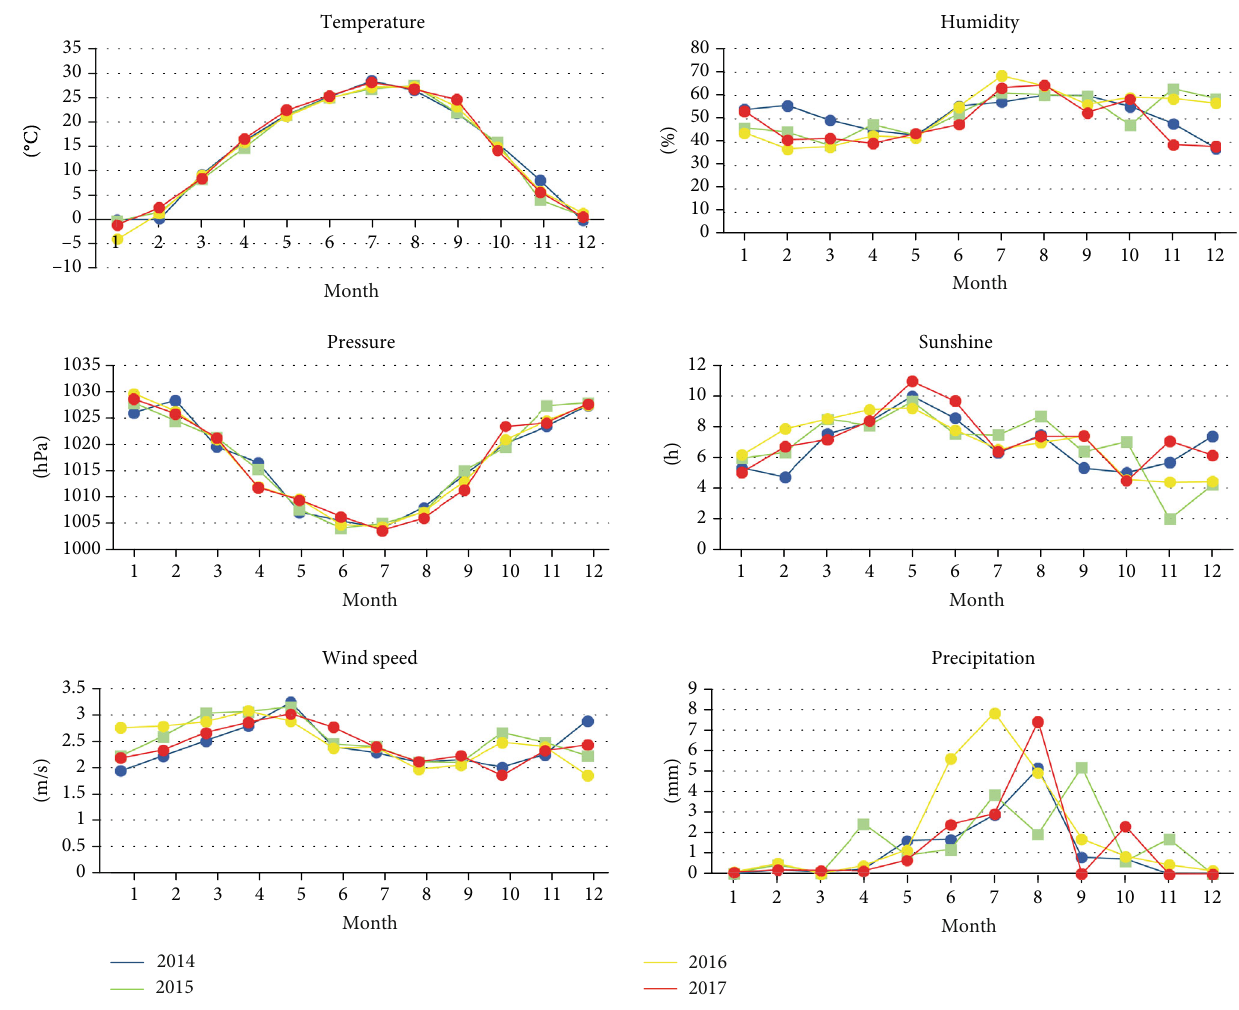
Figure 3: Monthly average changes in meteorological factors for 2014-2017. Table 4: Spearman correlation analysis between air pollutants and meteorological